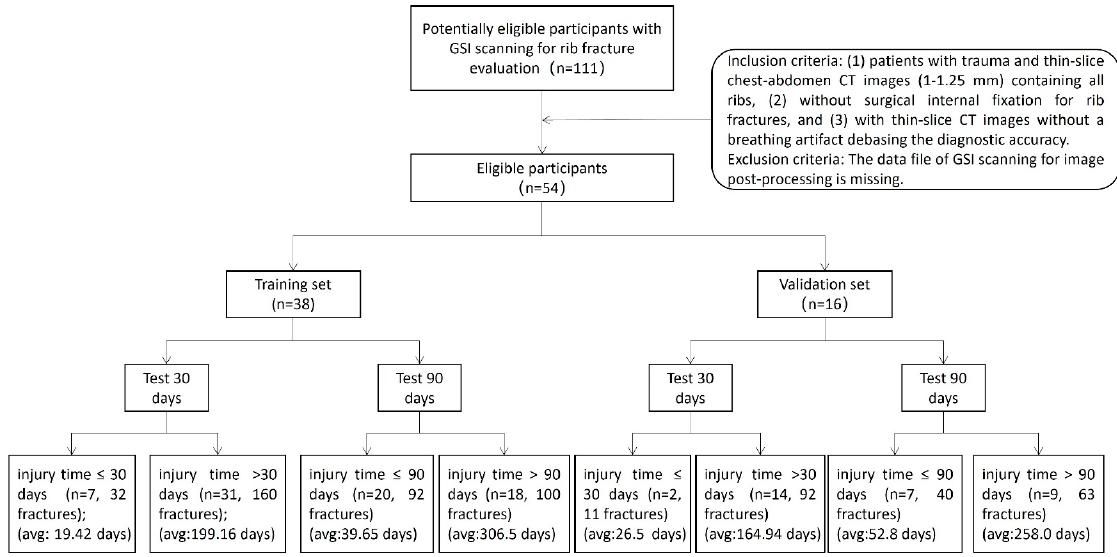
Figure 2. The patients’ enrollment.